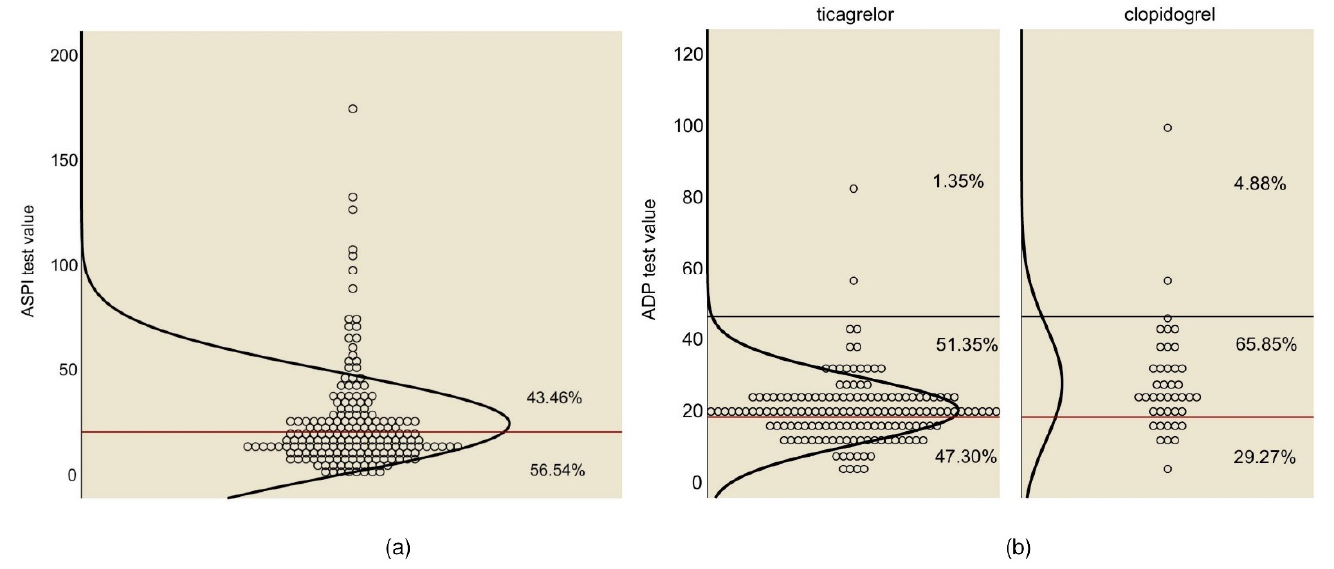
Figure 1. Response to antiplatelet therapy. ( a ) Response to aspirin treatment—the red line is drawn at 20, and the curve represents the normal distribution curve. ( b ) Response to P2Y12 inhibitor treatment, ticagrelor vs. clopidogrel—the red line is drawn at 18 and the black at 46, and the curve represents the distribution curve. Table 2. Factors analyzed according to aspirin response.